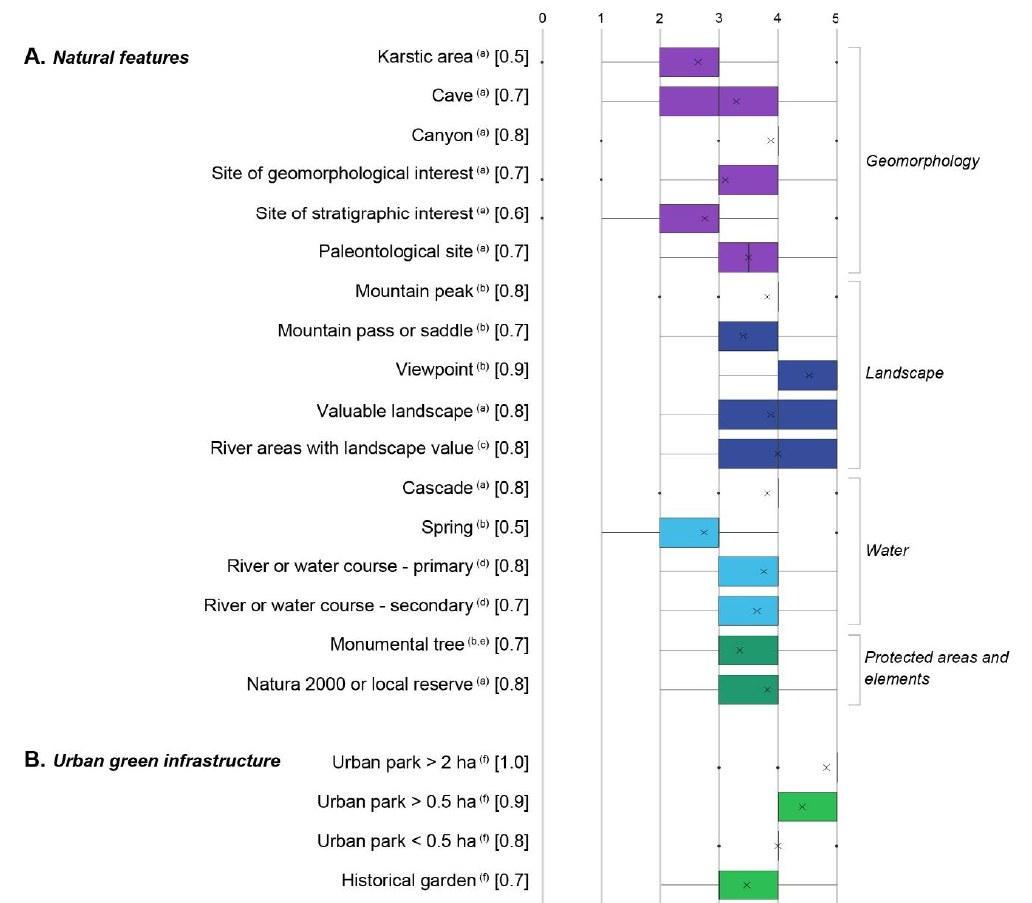
Figure 4. Box-plots showing the distribution of the scores assigned to the components of recreation potential by local experts. In square brackets are the final normalized scores used to run the model. Colors identify main categories of data. Data sources: (a) [56]; (b) [53]; (c) [57]; (d) [45]; (e) [58]; and (f) [59].